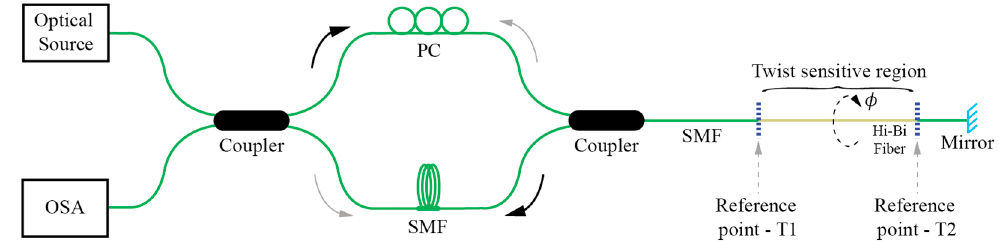
Figure 5. Twist sensor employing a loop mirror configuration with an output port probe.